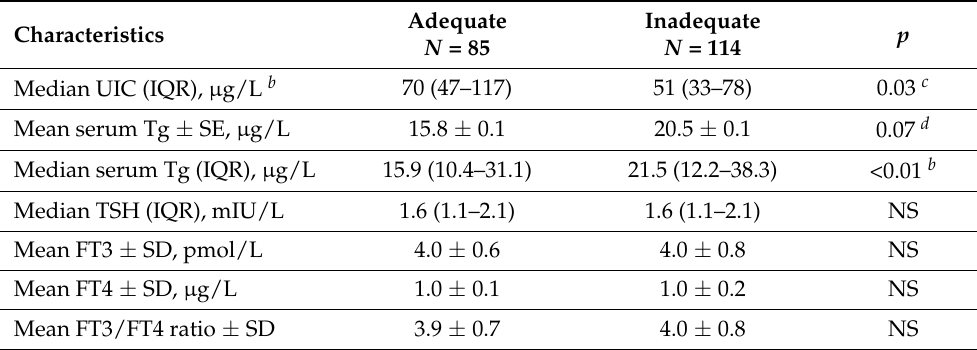
Table 2. Maternal iodine status and thyroid function tests a classified below and above EAR with the aid of sIFFQ for estimating iodine intake adequacy.